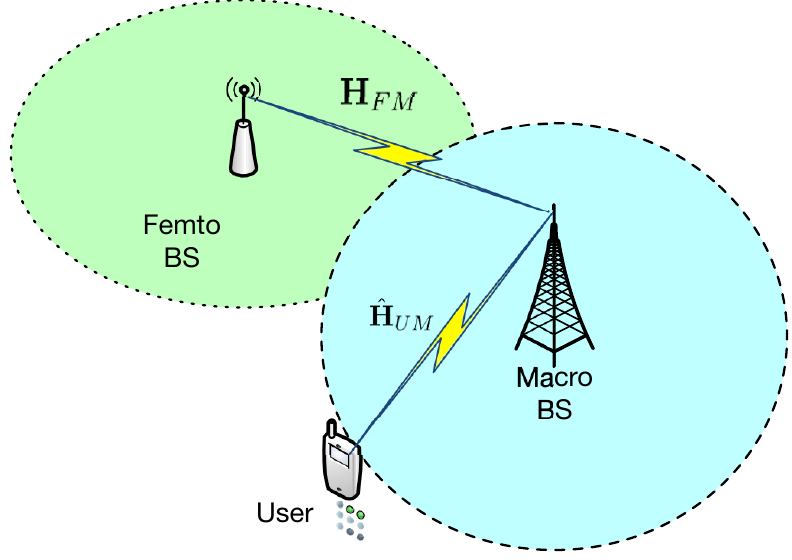
Figure 1. Secure MIMO communications for heterogeneous